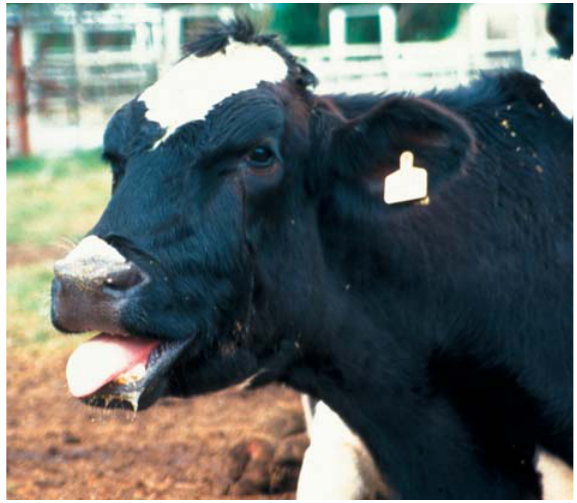
FIG. 2 Open-mouthed breathing as seen in the “summer syn- drome”